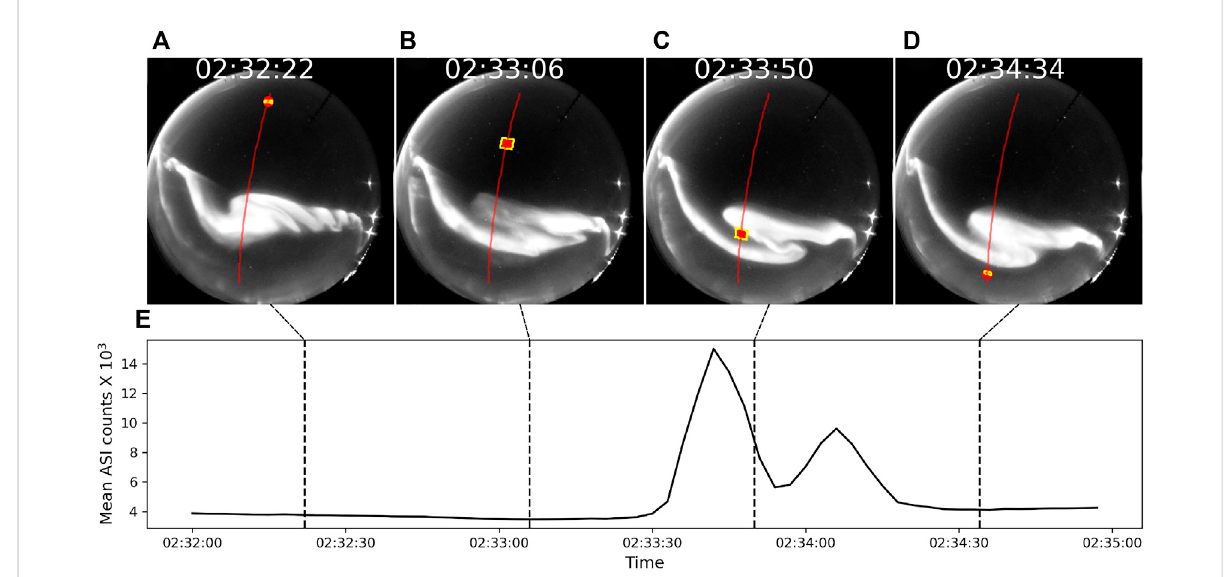
FIGURE 4 A conjunction montageof Supplementary VideoS2. Panels (A – D) shows the auroral arc evolution and the satellite ’ s location. The redline isthe satellite track and the red dot is its instantaneous position. The yellow quadrilateral bounds the pixels inside the 20 × 20 km area surrounding